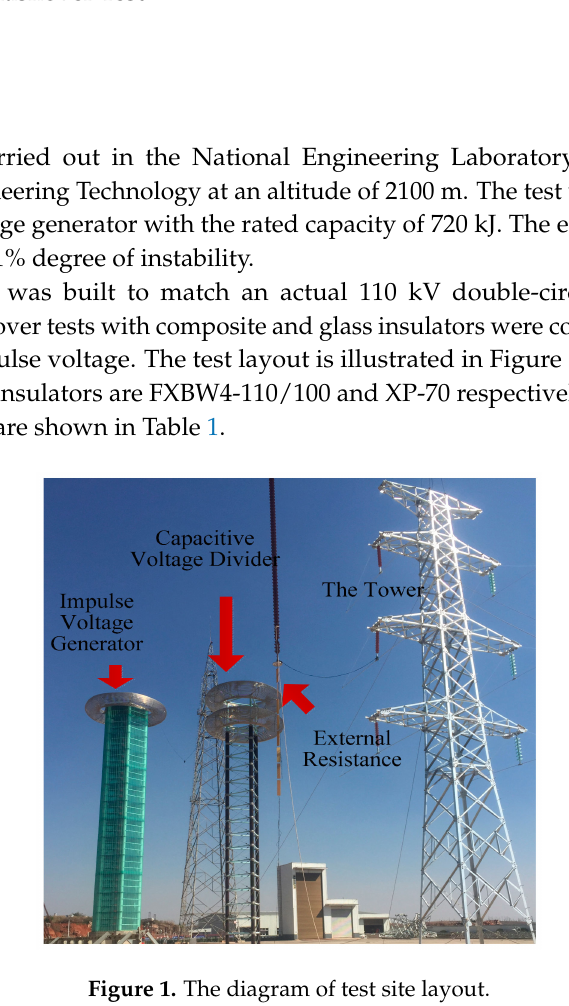
Figure 1. The diagram of test site layout. Table 1. The parameters of the